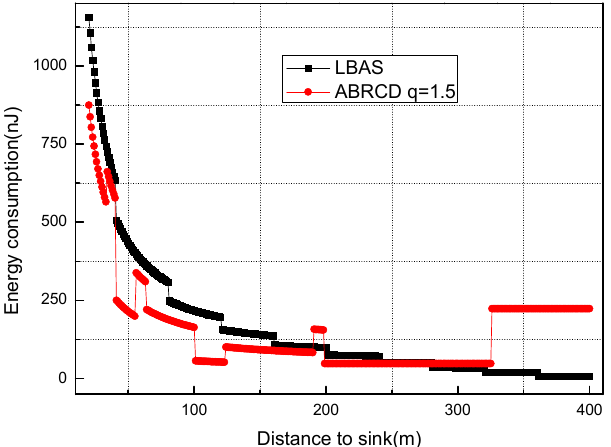
Figure 19. Energy consumption of nodes 1~19 m away from sink with different q (3.0, 3.5). Sensors 2018 , 18 , x FOR PEER REVIEW